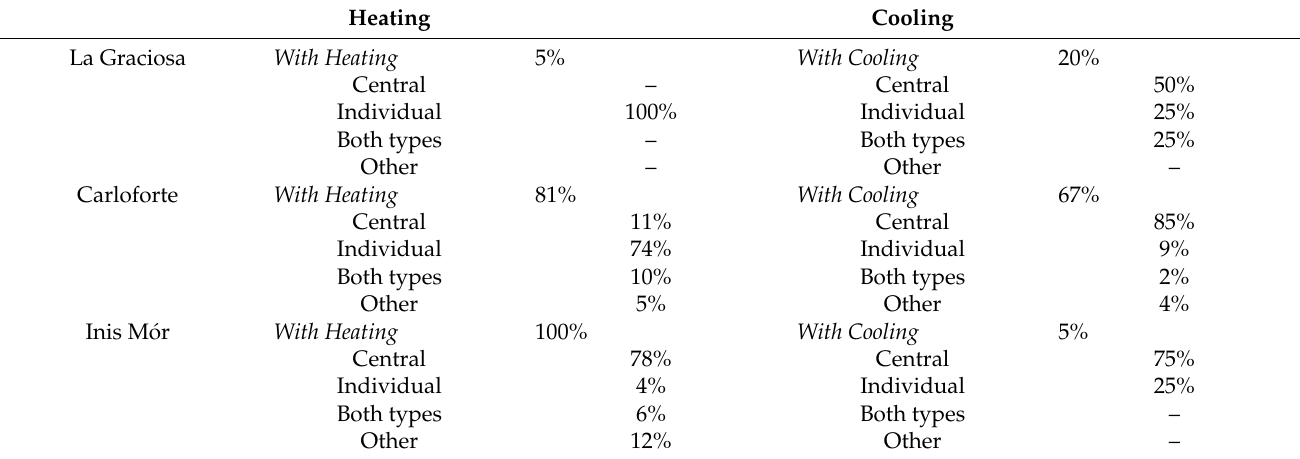
Table 2. Heating and cooling systems of the respondents in the three